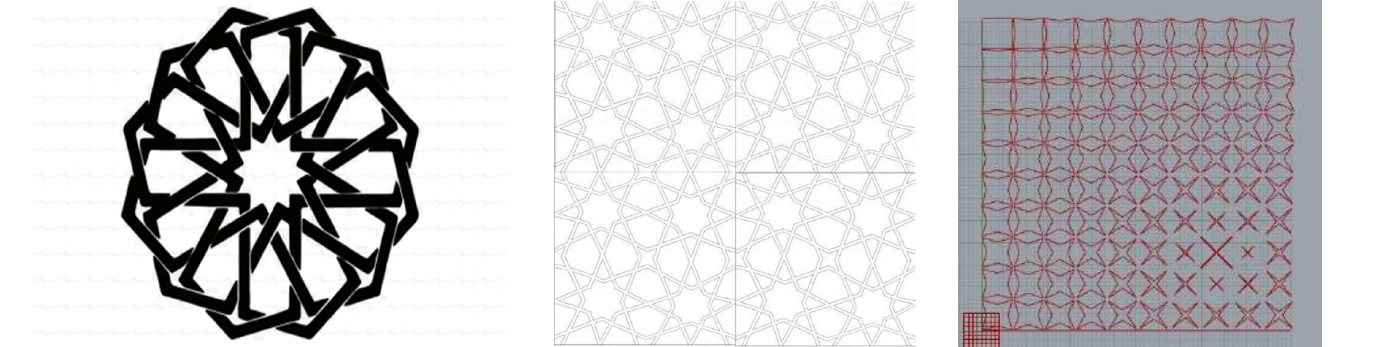
Figure 16. Design evolution of the parametric dynamic façade.